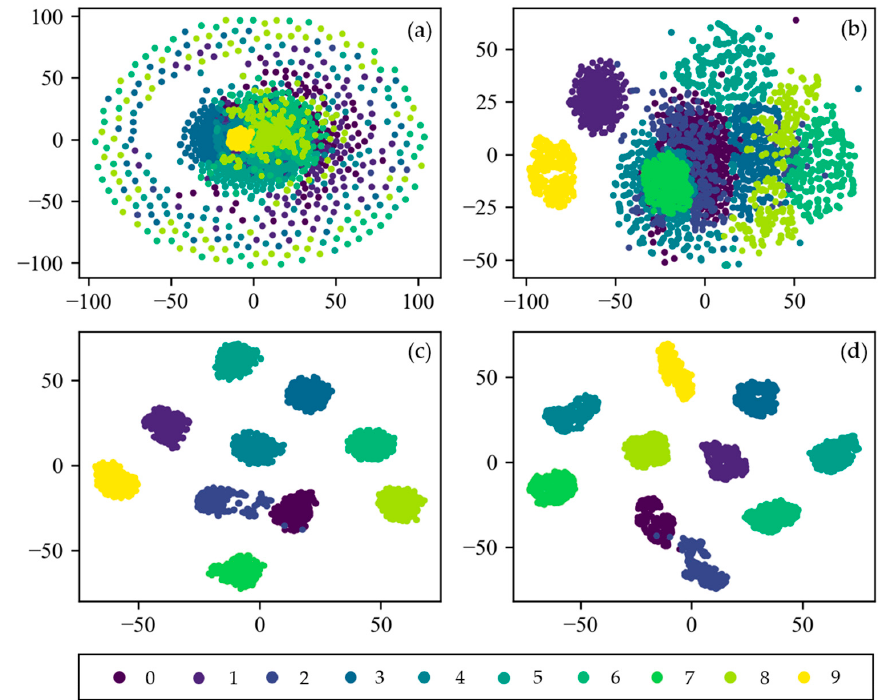
Figure 14. Feature visualization of CNN via t-SNE: ( a ) Raw Signal; ( b ) pooling Layer1; ( c ) pooling Layer2; ( d ) fully Connected Layer.